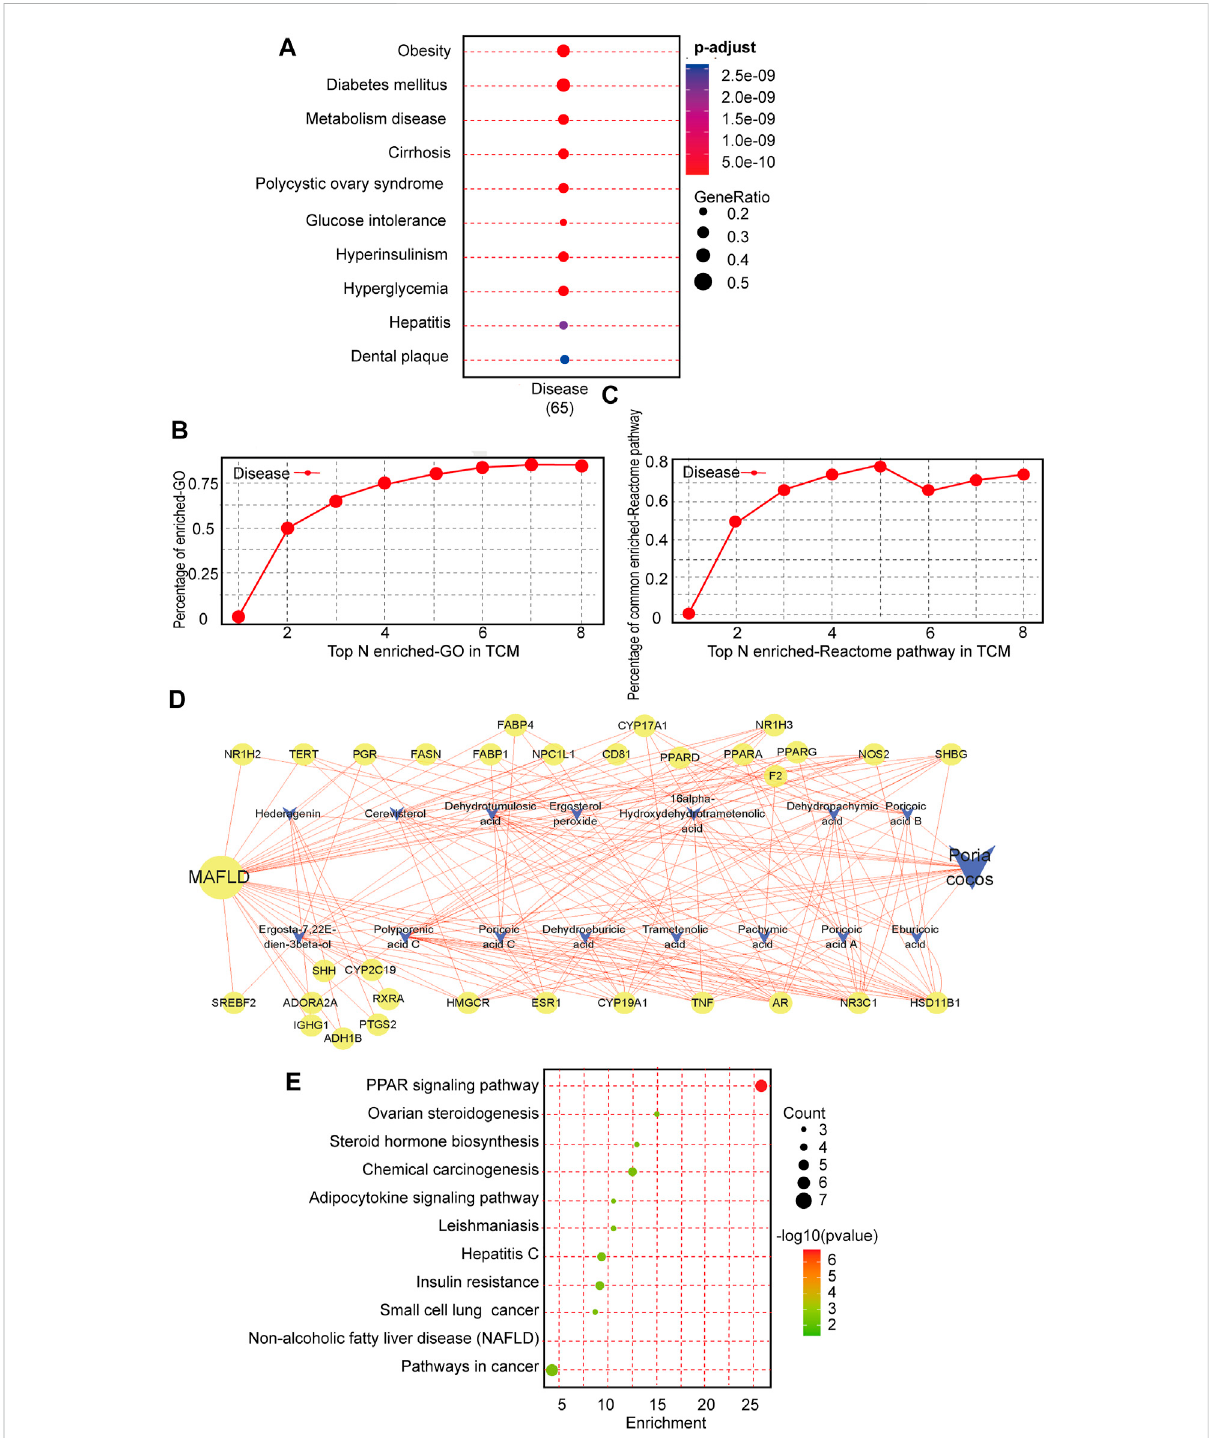
Intrinsic association and active compound identi fi cation of Poria cocos ( P. cocos ) for the treatment of MAFLD. (A) Metabolic dysfunction- associated fatty liver disease (MAFLD) Gene ontology (GO) enrichment. (B) Similarity of co-associated GO terms between P. cocos and MAFLD. The similaritybetweentheco-associatedGOtermsof P.cocos andMAFLDwas0.87,andtheareaunderthecurve(AUC)ofthetop30ofthesetermswas 4.84. (C) Similarity of co-associated Reactome pathways between P. cocos and MAFLD. The similarity between co-associated Reactome pathways of P. cocos and MAFLD was 0.78, and the AUC of the top 30 of these pathways was 4.47. (D) MAFLD- Poria cocos -target relationship network diagram. Nodes of higher degree value are indicated by a larger diameter and darker color. Stronger interactions between nodes are indicatedwiththickeredgesanddarkercolors.Greenrepresentsthetargets,orangerepresentsthecompound,andbluerepresentsthedisease. The circlerepresentsthetargetand “ V ” representstheactivecomponentof P.cocos . (E) TheKyotoencyclopediaofgenesandgenomes(KEGG)pathway enrichment analysis of key